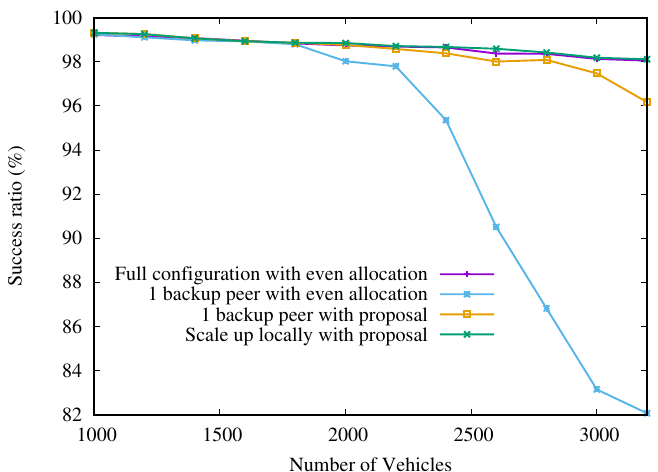
Figure 15. Success ratio performance of the system with a backup